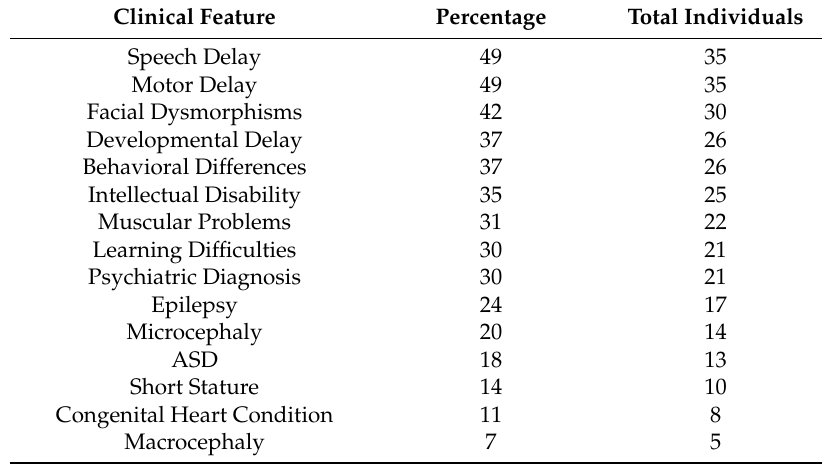
Table 3. Frequency of clinical features in the 71 probands with the 15q11.2 BP1-BP2